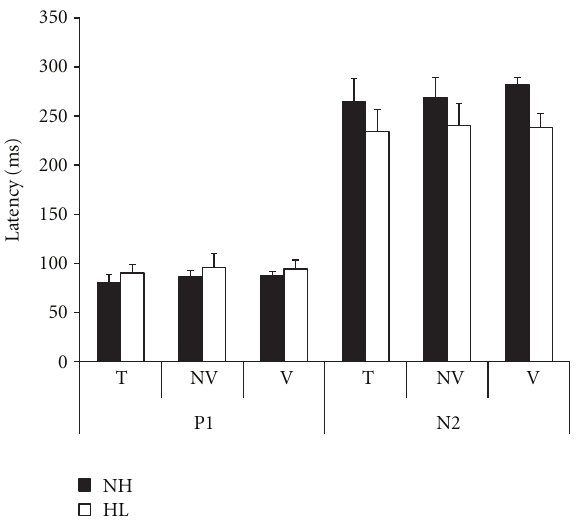
Figure 2: P1 and N2 mean latency values and standard deviation recorded of five children with hearing loss (HL) and five children with normal hearing (NH) with 1kHz pure tone (T), nonverbal /ba/ (NV), and verbal /ba/ (V) stimuli.